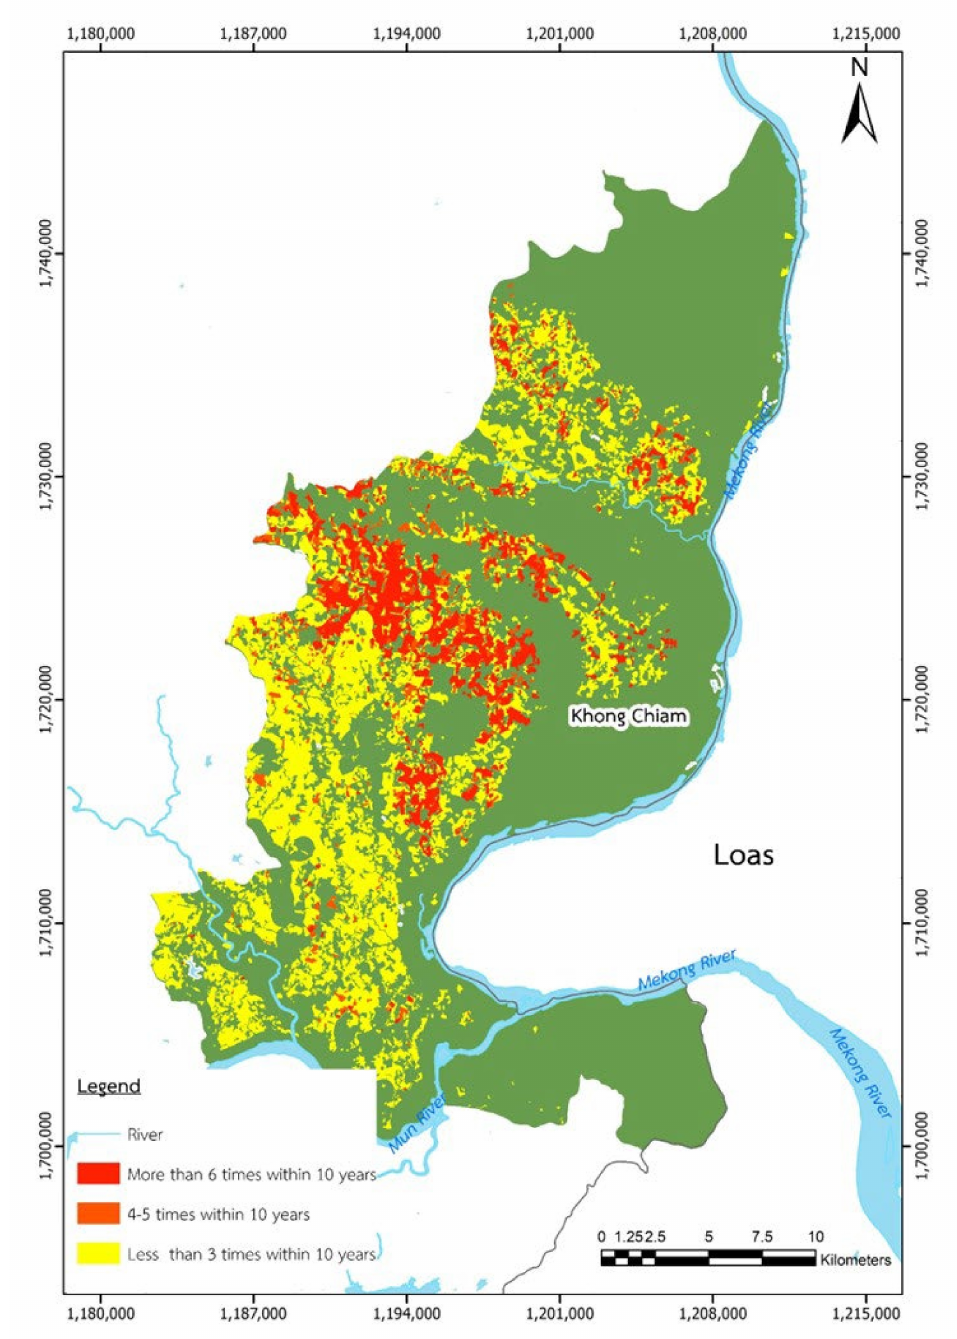
Figure 2. Khong Chiam City, Ubon Ratchathani, Thailand (case